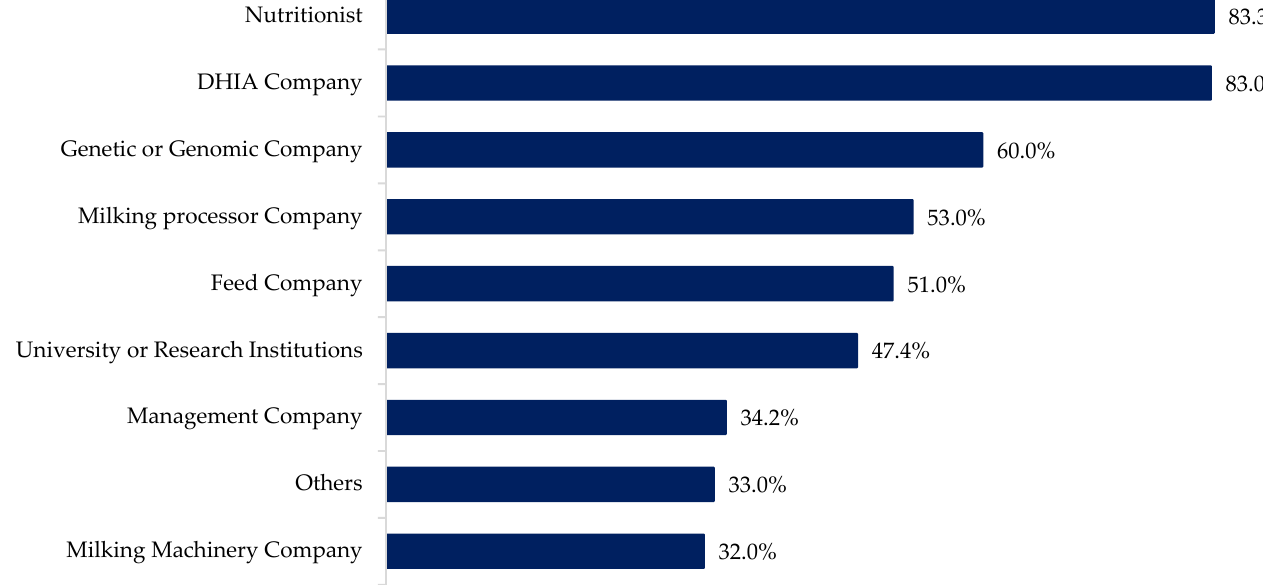
Figure 2. With whom outside the organization farmers are sharing their data.